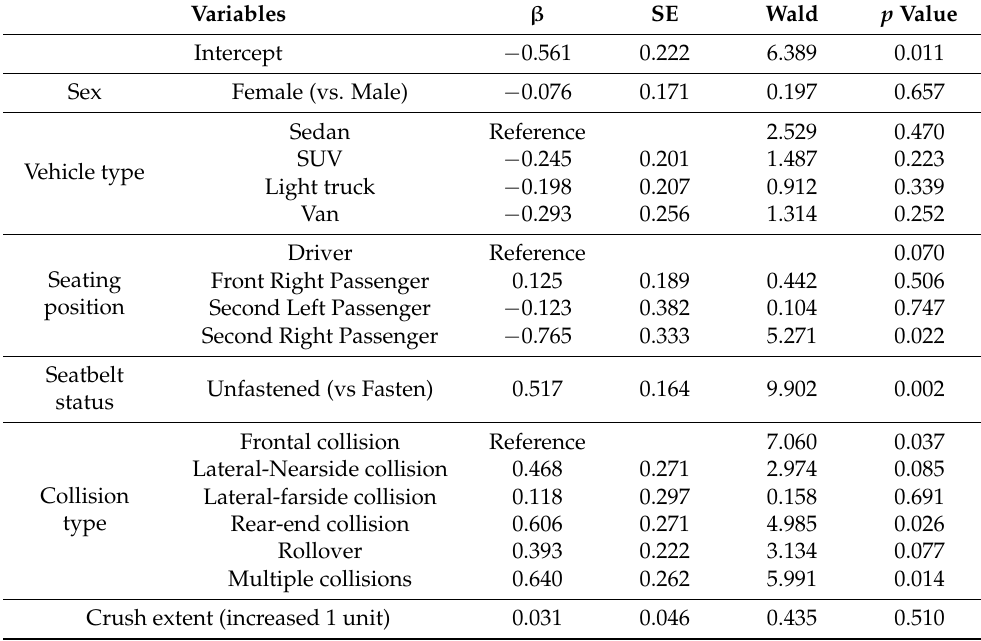
Table 3. Beta coefficients for the variables retained in the logistic regression